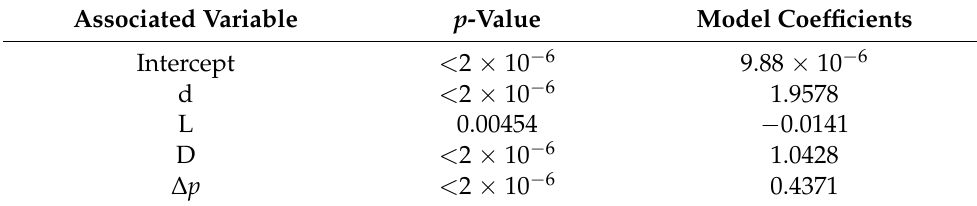
Table 3. Model coefficient and significance analysis: mass flow rate.